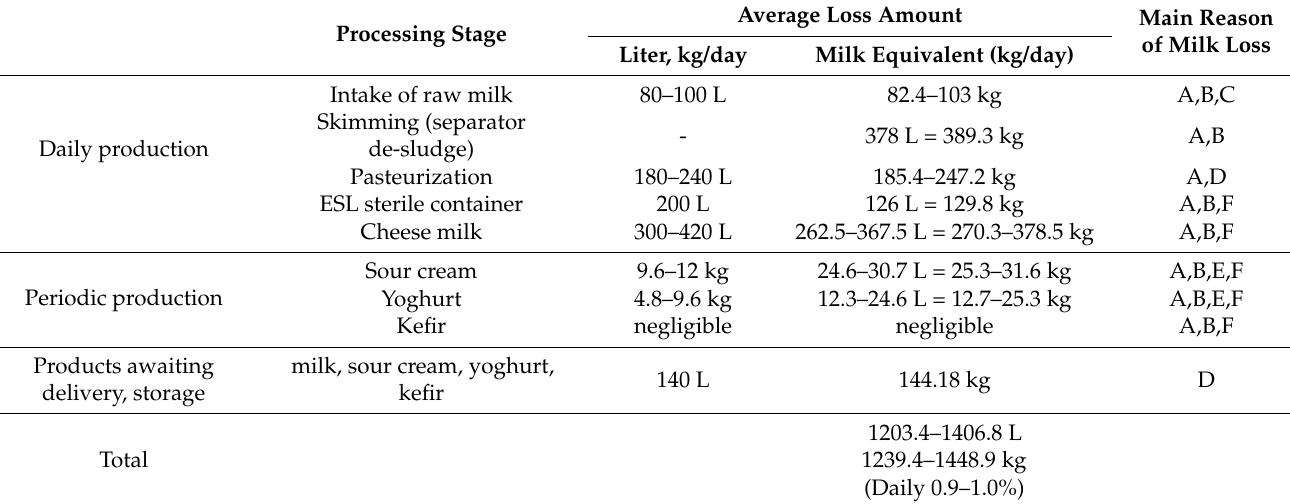
Table 2. Amount of and reasons for dairy losses at each stage of